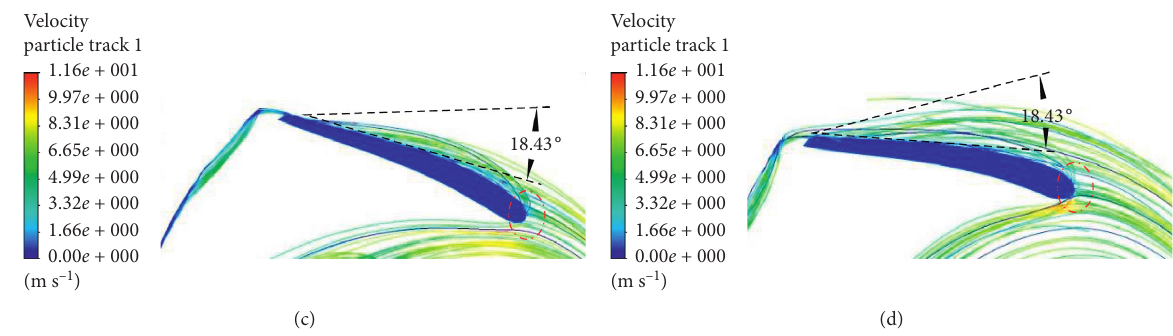
Figure 13: Comparison of particle motion track after optimization. (a) Optimized. (b) Original prototype. (c) Optimized. (d) Original